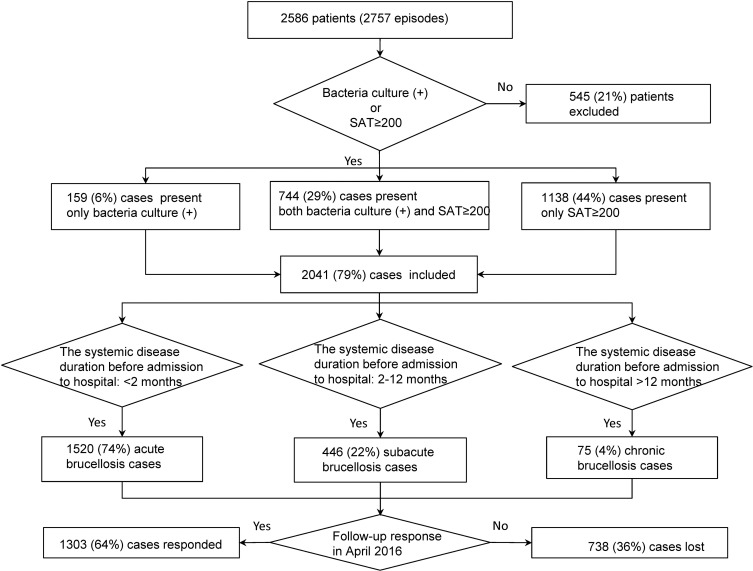
Flowchart for enrollment of 2041 brucellosis confirmed cases in Xinjiang, China, 2014.